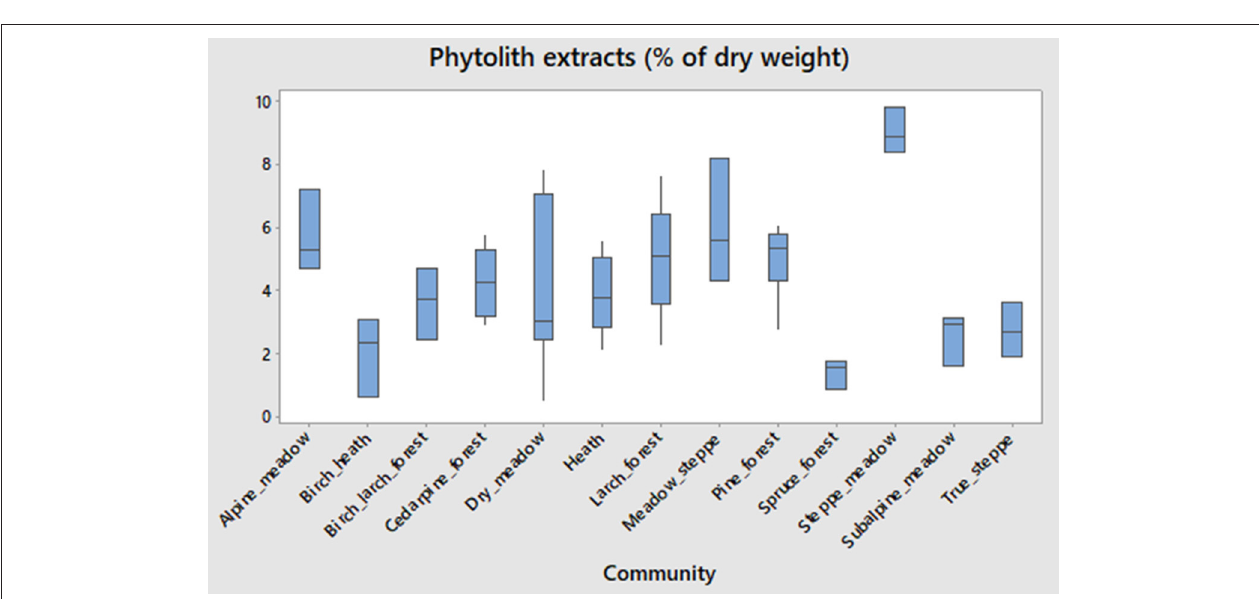
FIGURE 4 | Boxplots quantifying phytolith extracts (% of original sample dry weight) by community.